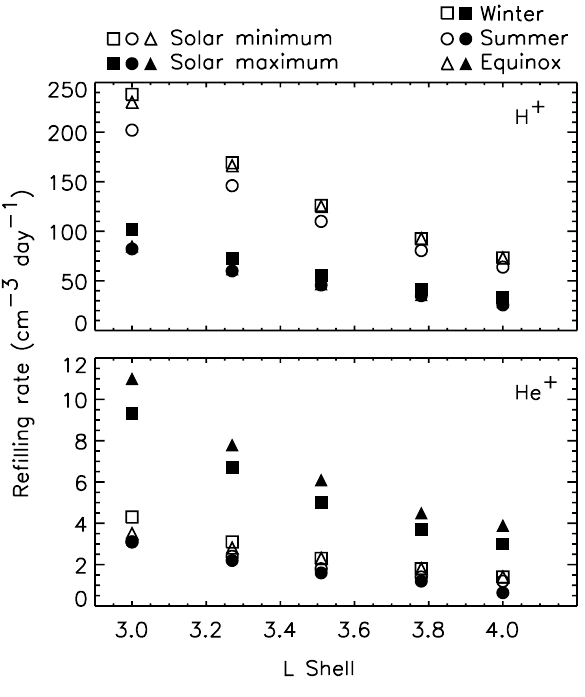
Fig. 7. Late-stage refilling rates for H + (top) and He + (bottom). All rates correspond to the magnetic equator and longitude 270 ◦